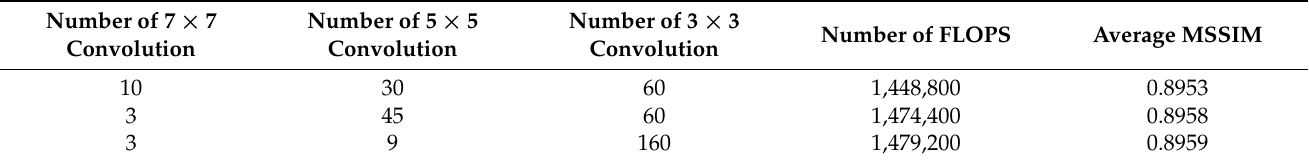
Table 4. Performance for the combination of convolutions with different numbers of 7 × 7, 5 × 5 and 3 × 3 filters and layers in the neural